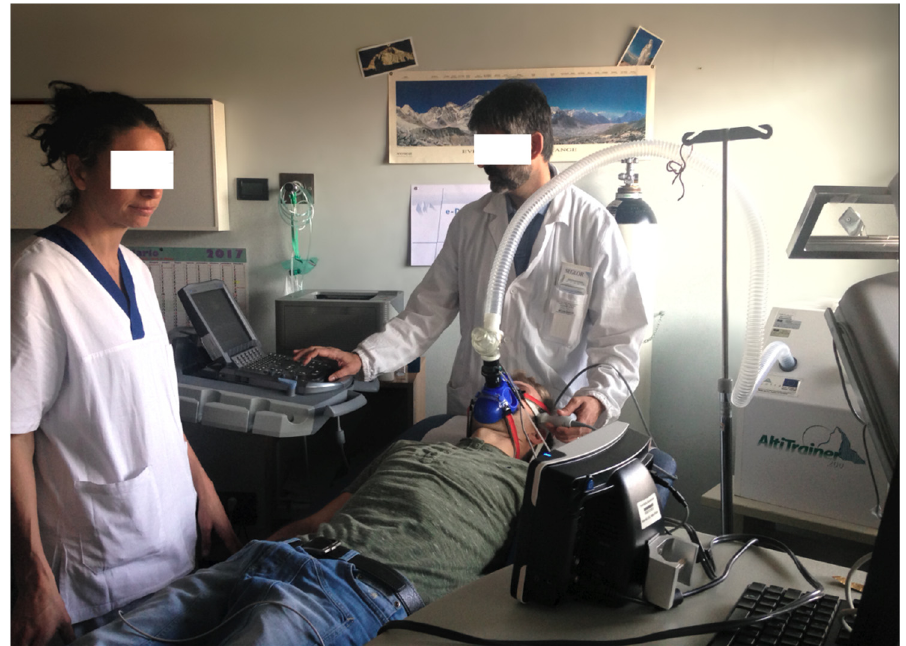
Figure 3. Cardiopulmonary rest test and cerebral blood flow (CBF) measurements in normobaric hypoxia (FiO 2 14%).